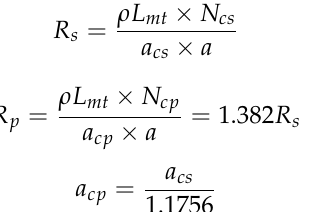
Figure 5. Equivalent circuit of a combined star–pentagon winding measuring the resistance between ( a ) adjacent phases, R adj , and ( b ) non-adjacent phases, R Nadj . The per-phase resistance of the star-connected winding is given by (5), and the per- phase resistance in the pentagon winding is given by (6). Based on the relation between the the conductor’s cross-sectional area can be described as in